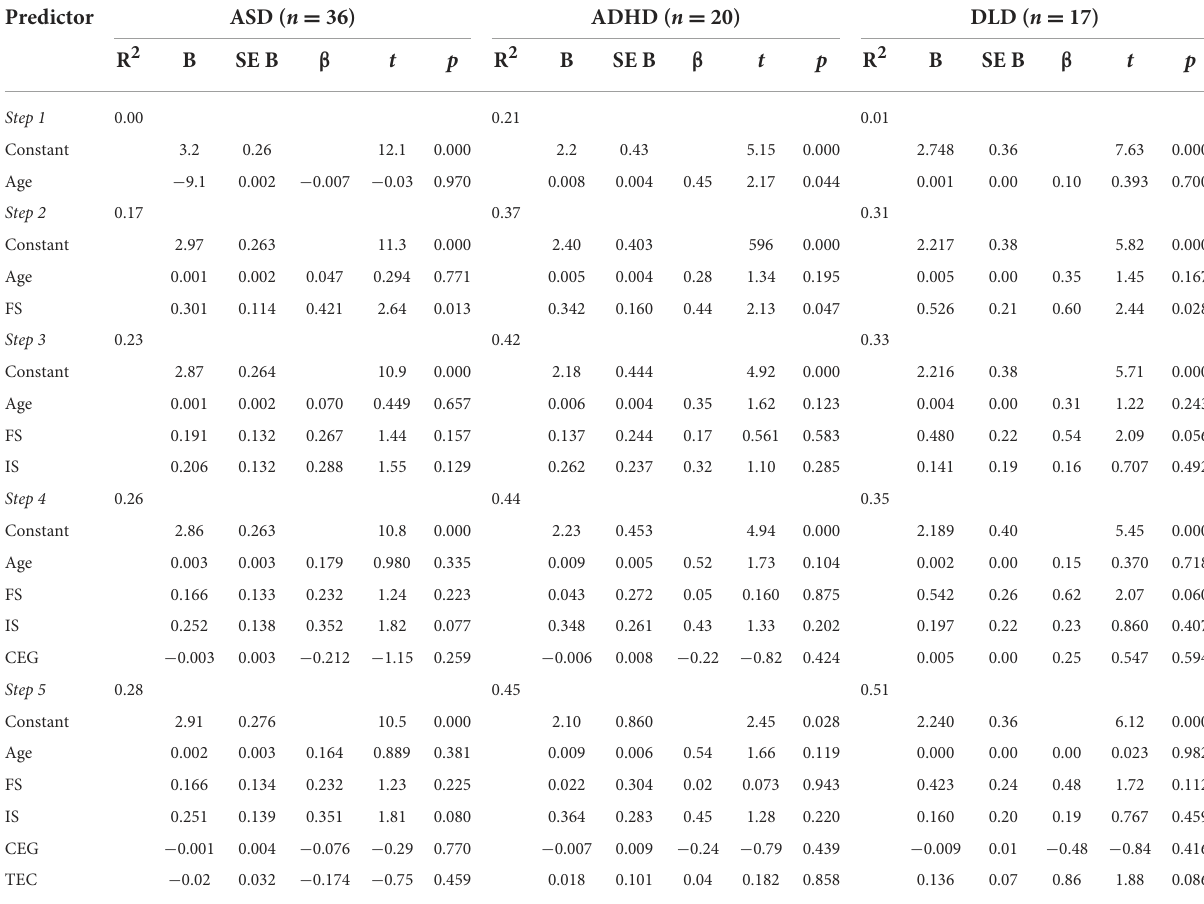
TABLE 4 Summary of the regression coefficients of Resilience Scale total scores within the ASD, the ADHD and the DLD group.